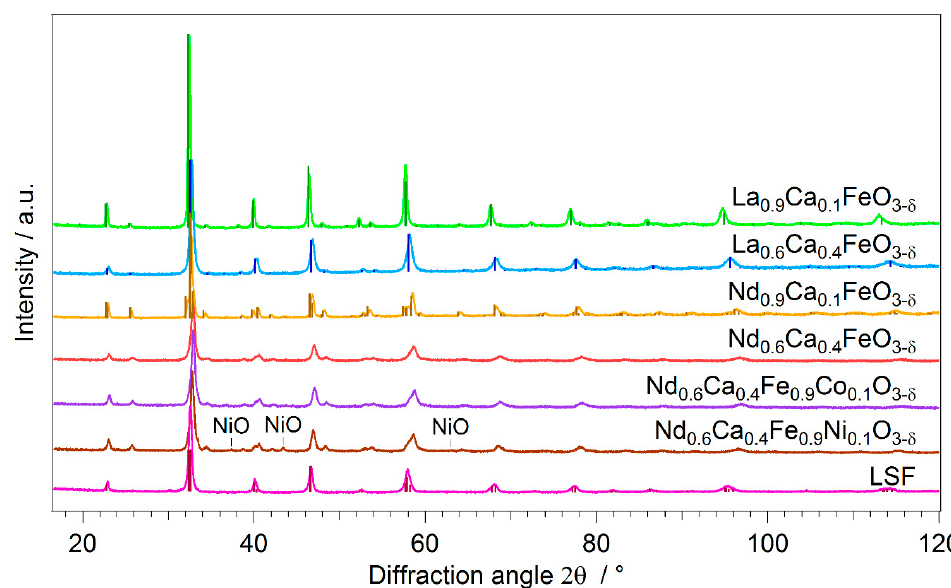
Figure 1. XRD patterns of the novel perovskites after synthesis and of La 0.6 Sr 0.4 FeO 3- δ (LSF) as reference material. The bars are indicating the reflex positions of reference structures obtained from database entries for the respective materials. All perovskites were phase pure, except for the Ni-doped one, which showed trace amounts of NiO. Table 1. PDF-numbers of the reference structures used in Figure 1, BET surface areas of the different perovskite materials and average specific activities calculated for CO 2 production during high temperature water–gas shift (HT-WGS) at 600 °C.